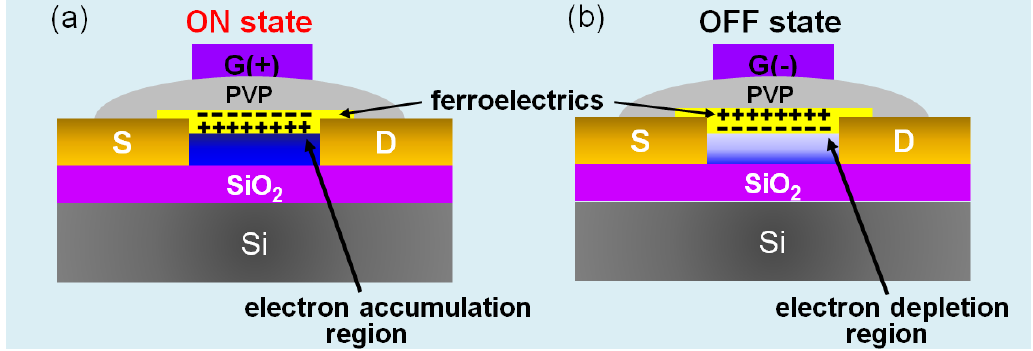
Figure 1. Schematic views of ferroelectric liquid crystal (LC)-coated ZnO nanowire field effect transistors (FETs) exhibiting charge accumulation and depletion in the channel. ( a ) The ON memory state; ( b ) the OFF memory state. PVP,